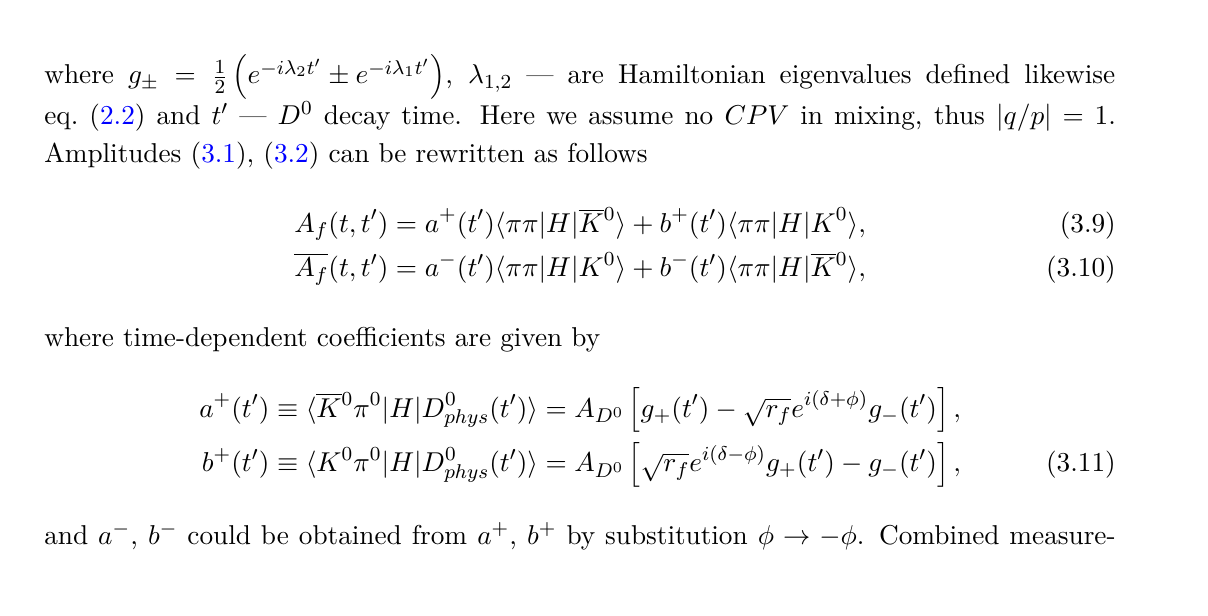
Figure 2 . At the top plot time-dependent decay rates obtained with MC simulation are shown. Black and open circles represent data simulated according to decay rates (3.5), (3.6) respectively. In the middle plot the asymmetry defined as (3.7) is shown. The bottom plot illustrates the difference between asymmetries with and without DCS contribution. For these plots we used √ r f = 0 . 06 and δ 0+ = 76 ◦ −